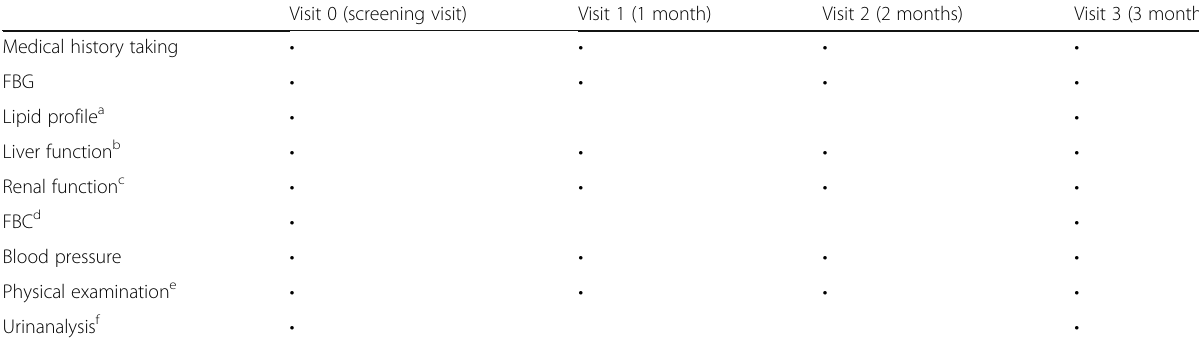
Table 1 Summarized study schedule at each visit in the clinical trial Visit 0 (screening